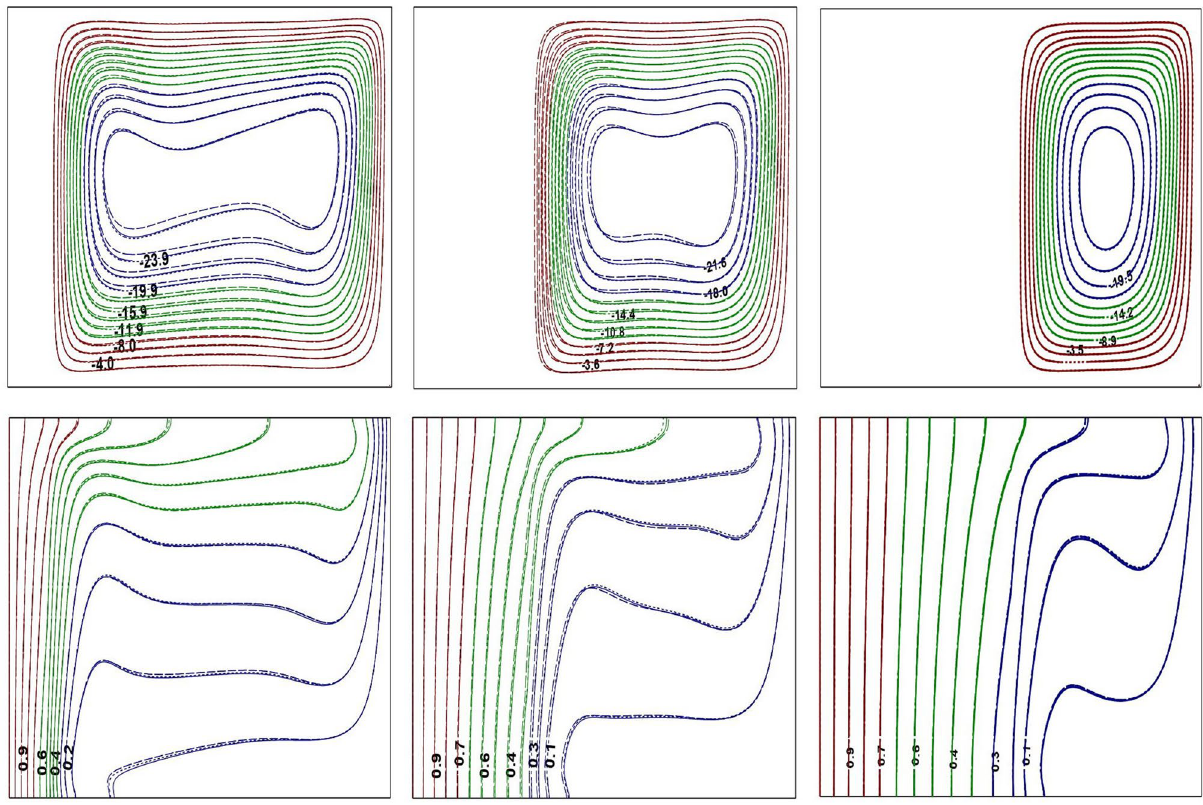
6 , φ = 0.1 and Kr = 2 . ε = 0.1 (left), ε = 0.3